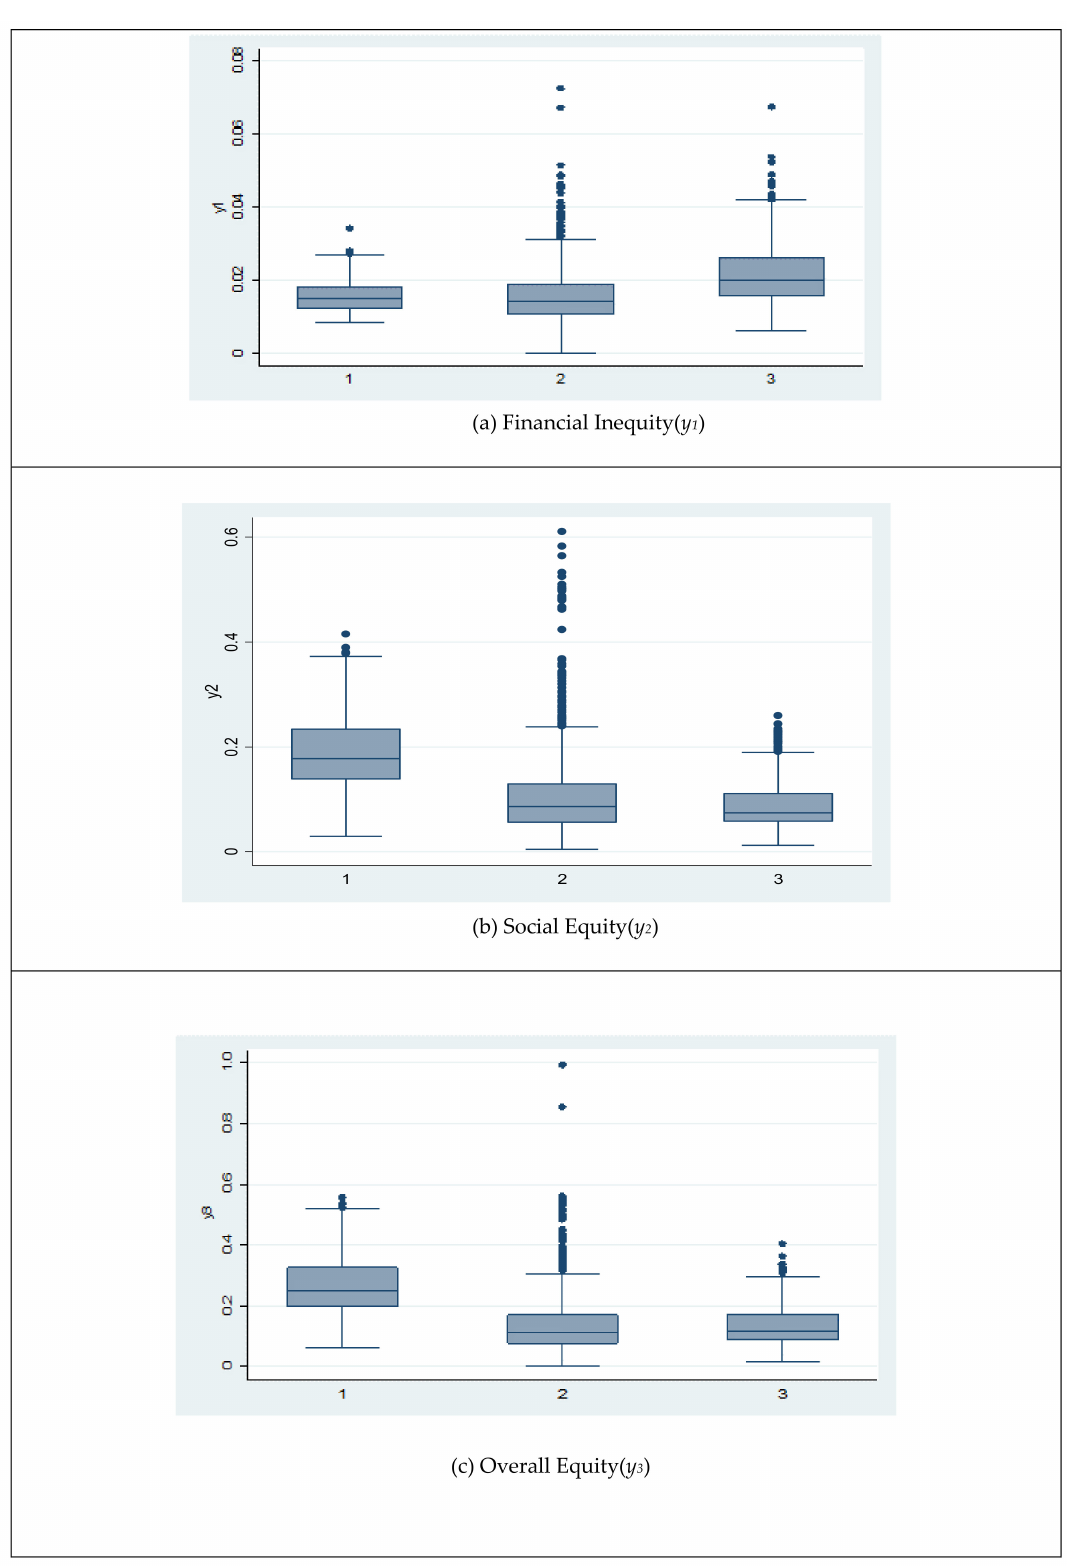
Figure 2. Comparing equity indicators across di ff erent sectors (2008–2012). Note: 1 = Government ownership, 2 = nonprofit organization ownership, 3 = individual